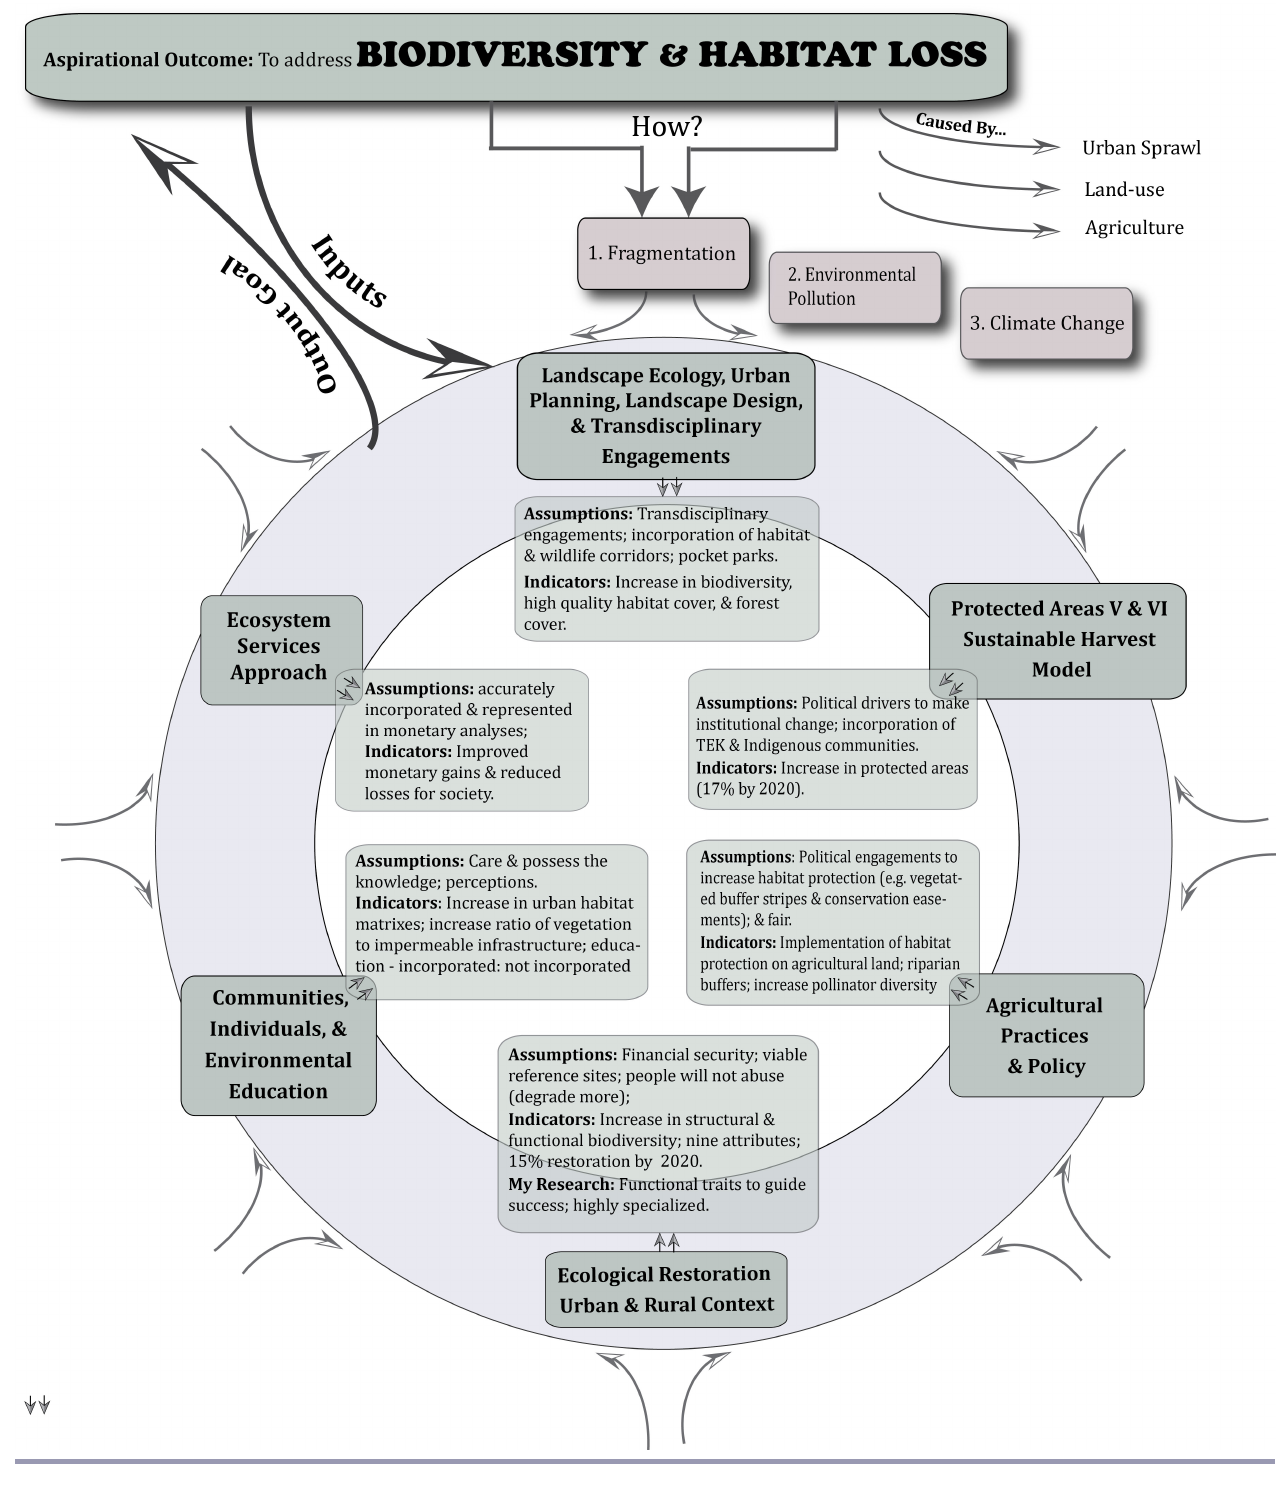
Fig. 3. Example theory of change: biodiversity and habitat loss in southern Ontario (S.